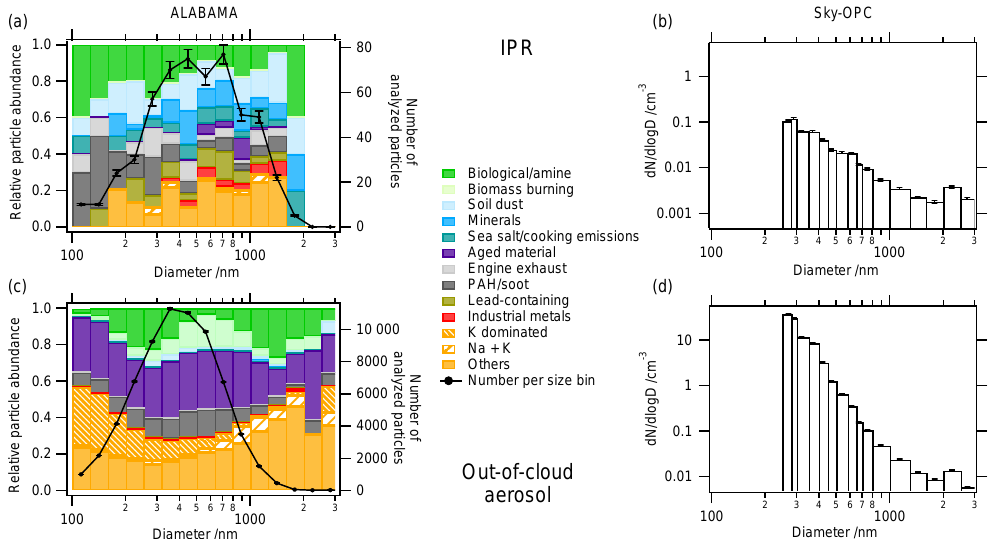
Figure 4. Size-resolved abundance of particle types in IPRs (a) and out-of-cloud-aerosol particles (c) sampled with the ALABAMA and the measured size distribution of the Sky-OPC (Ice-CVI: b ; total: d ). The black lines in (a) and (c) refer to the numbers of particles per size bin (right ordinate) of which a mass spectrum was obtained by ALABAMA with error bars based on counting statistics. The errors of the Sky-OPC data result from Gaussian propagation of uncertainty, including counting statistics, the manufacturer-given error of the OPC of 3% and the error of the enrichment factor (4%).